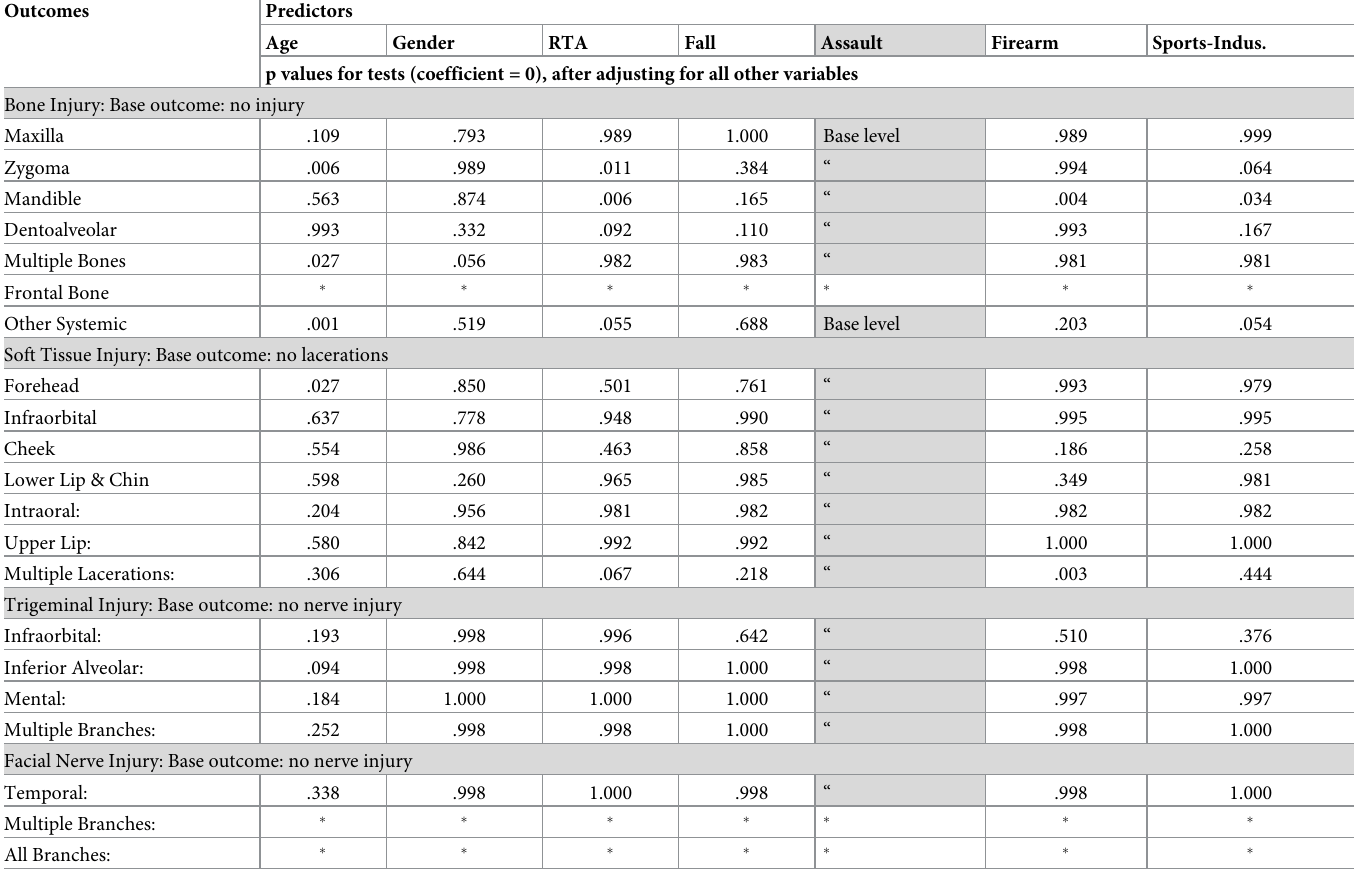
Table 3. Multivariate analyses (Multinomial Logistic